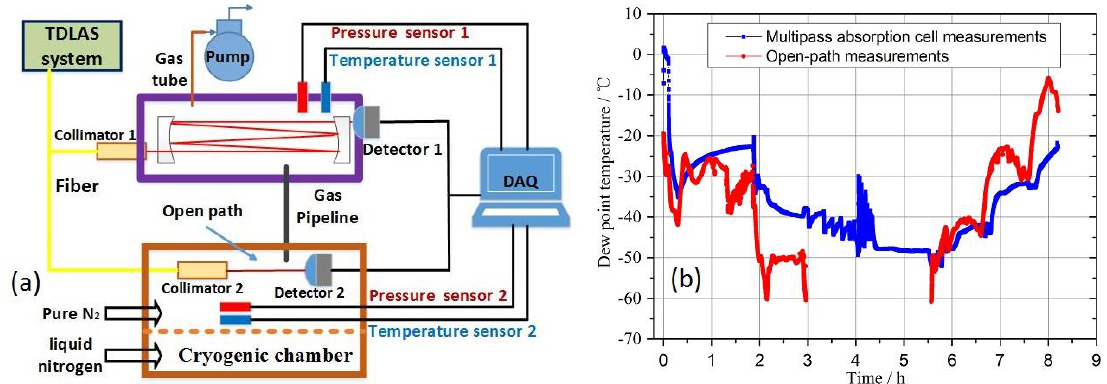
Figure 9. ( a ) The schematic diagram of a setup to verify impacts of gas pipeline absorption on water vapor concentration and dew point determination. DAQ: data acquisition and processing; ( b ) Results based on long multipass and short open-path absorption measurements. Note: during the very low water vapor concentration and dew point temperature time interval (3–5.5 h), the short open-path did not have sufficient sensitivity to make measurements.